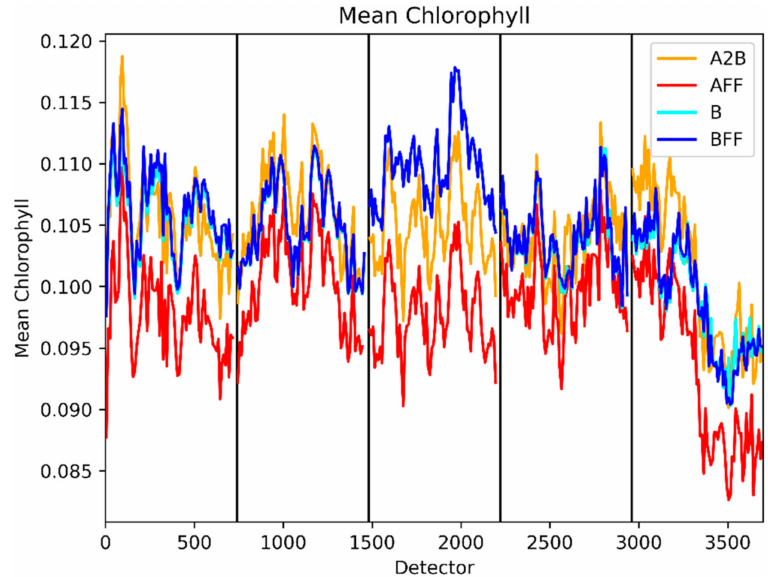
Figure 26. ALT-averages of chlorophyll over SPG for the four calibration